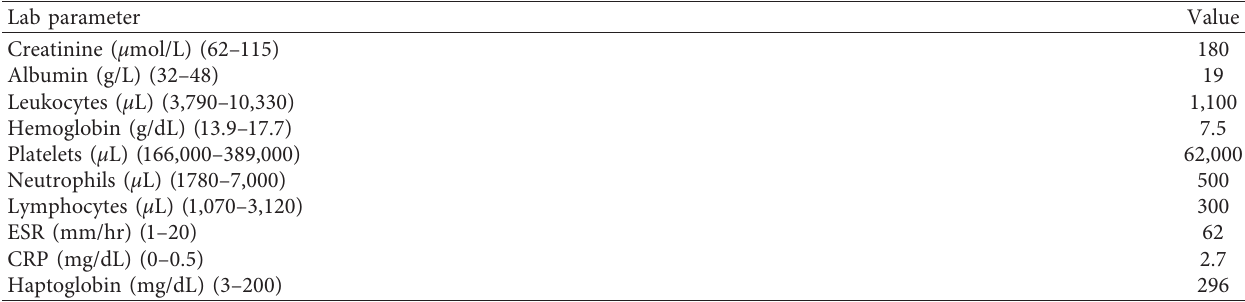
Figure 1: Lichen planus-like lesions on the patient’s back. On biopsy, the positive lupus band test was found, signifying immune complex deposition. Table 1: The patient’s blood chemistry and counts upon admission.